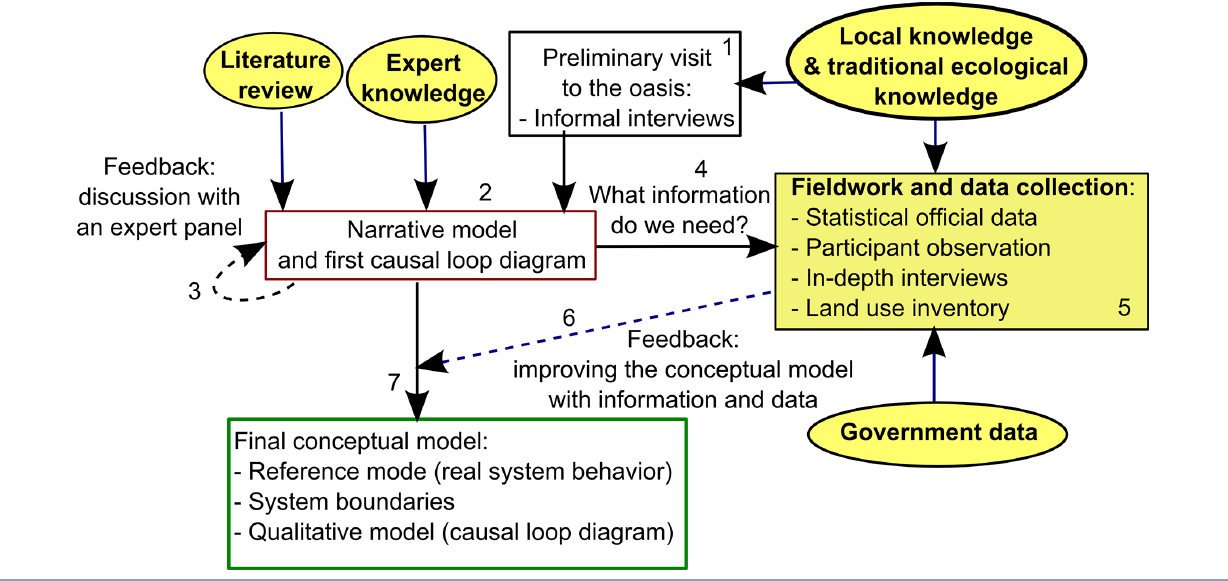
Fig. 3 . The conceptualization process. Numbers indicate the order of the methodological steps. The main information sources are marked in yellow. Dashed lines imply information